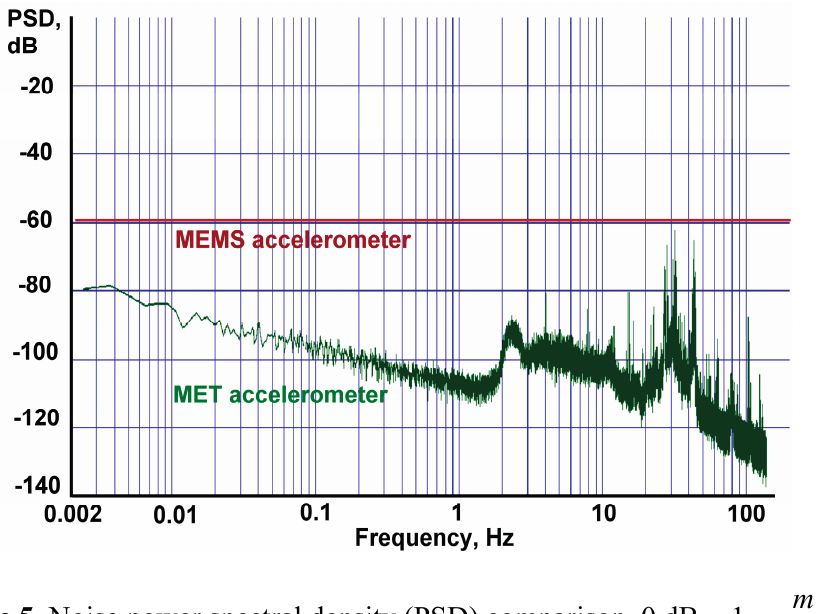
Figure 5. Noise power spectral density (PSD) comparison, 0 dB = 1